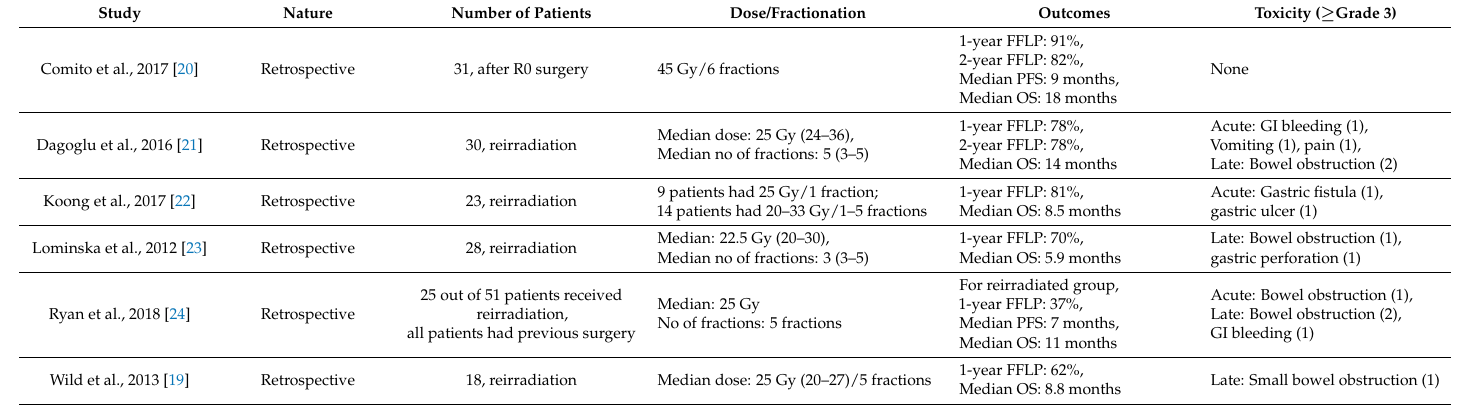
Table 2. Summary of studies utilizing SBRT for treatment of local